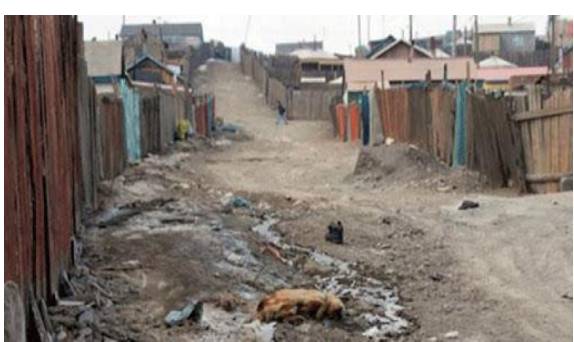
Figure 7. Street of ger area of Ulaanbaatar, Mongolia